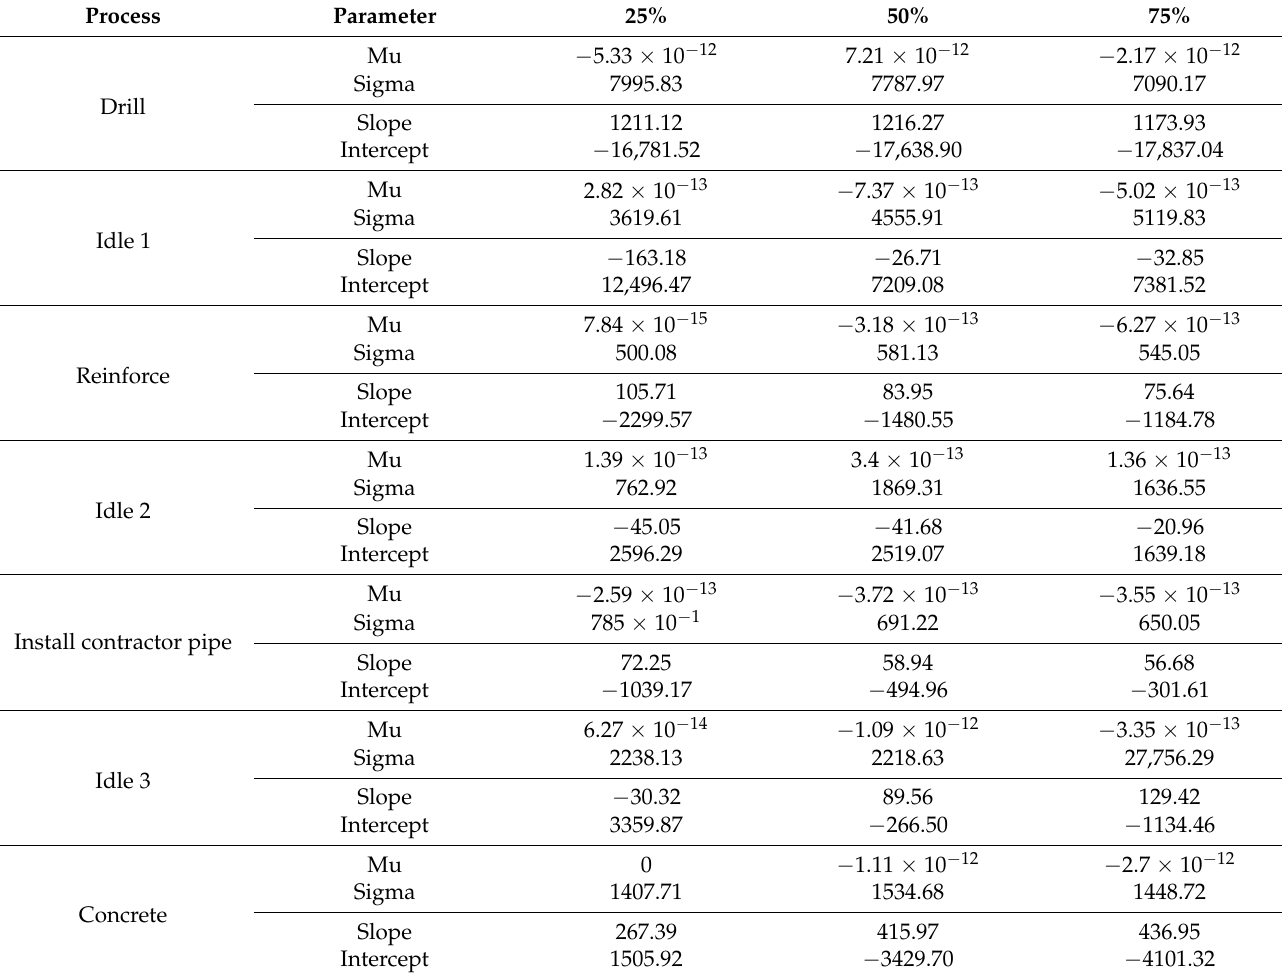
Table 4. Parameters for the linear regression and residuals depending on the process.